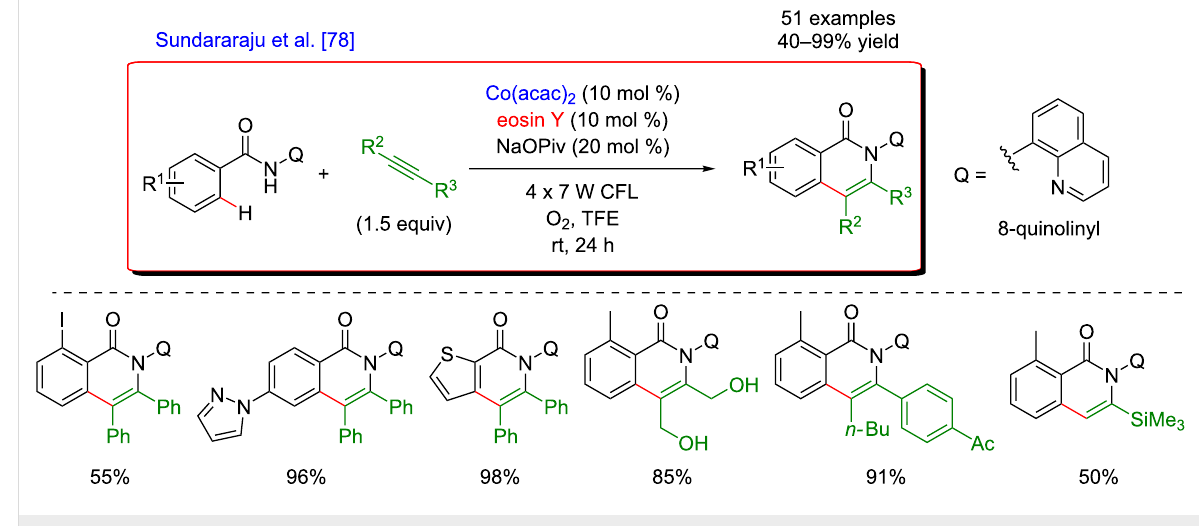
Figure 15: Annulation of benzamides via the dual C–H activation/photoredox catalysis.